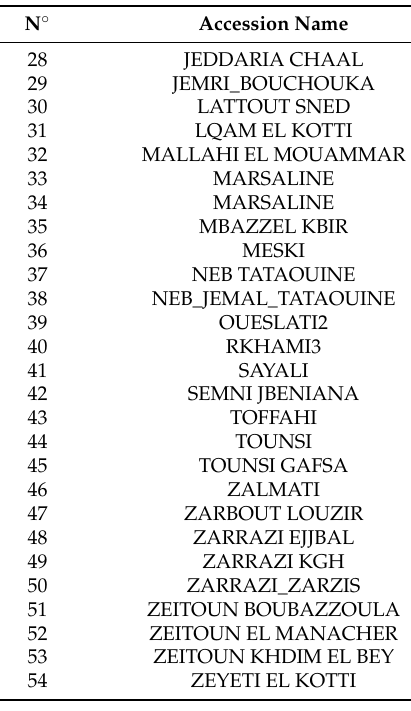
Table 2. List of accessions conserved at Tunisian olive national collection of Boughrara, accessible at